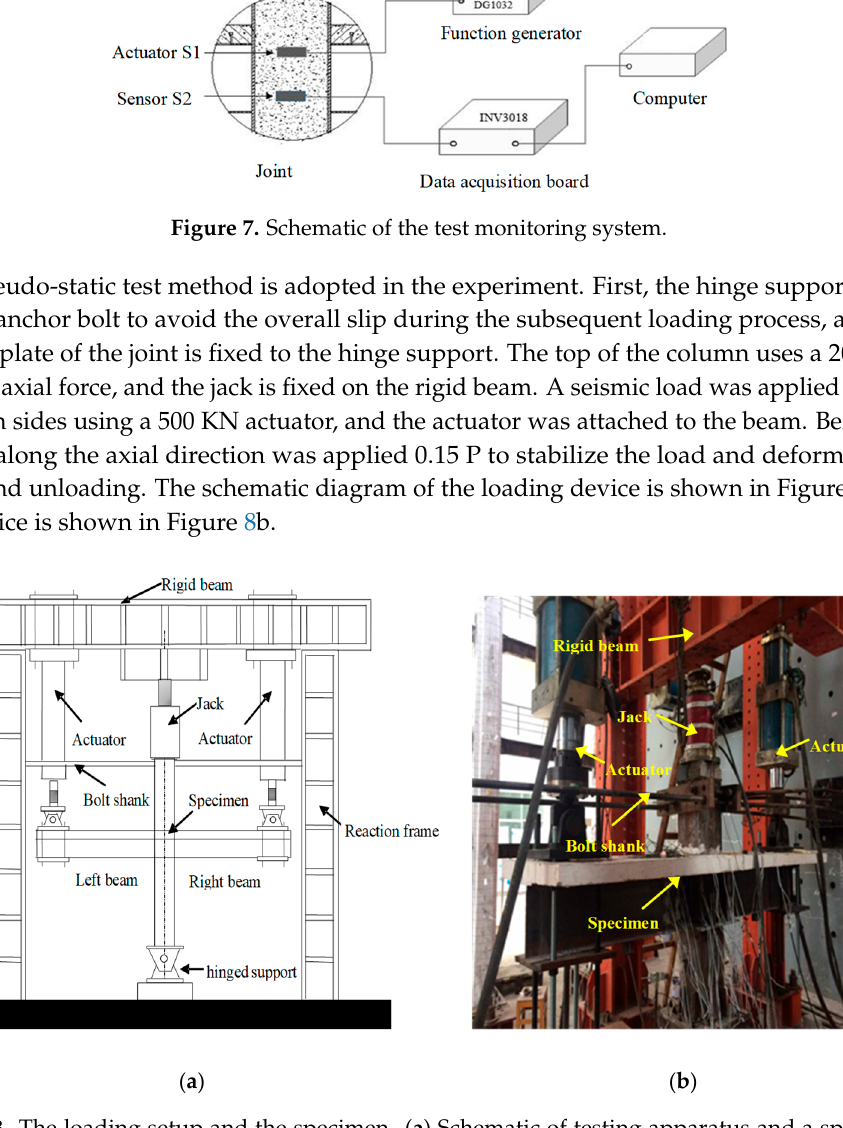
Figure 8. The loading setup and the specimen. ( a ) Schematic of testing apparatus and a specimen; ( b ) A photo of the testing setup and a specimen.